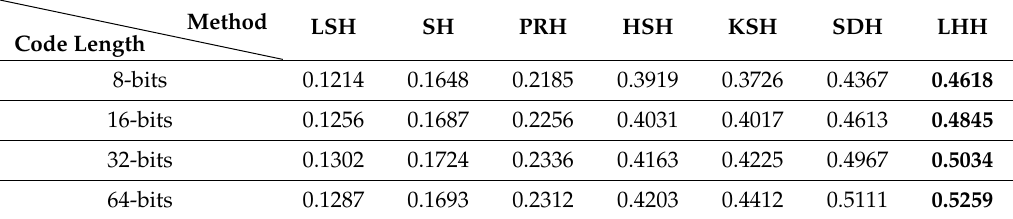
Table 6. Comparison of mAP with di ff erent hash code lengths on